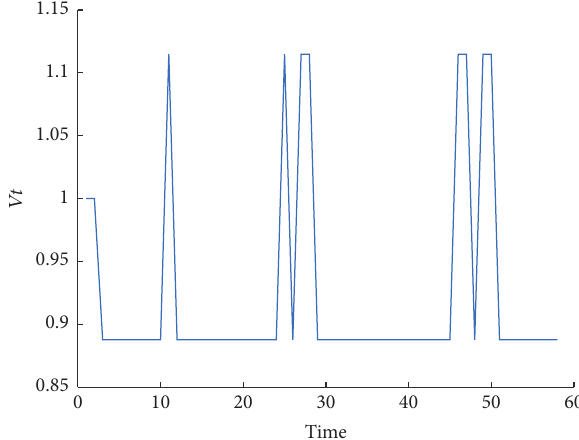
Figure 15: The change of velocity of the OMR controlled by dynamics